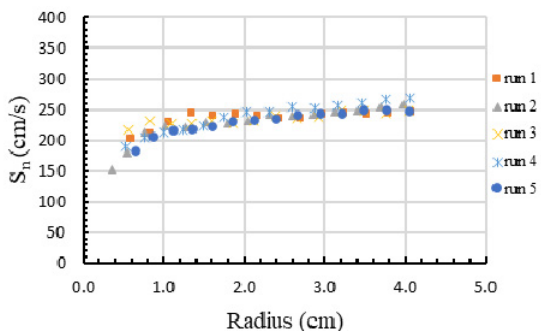
Figure 3. Fuel injection unit